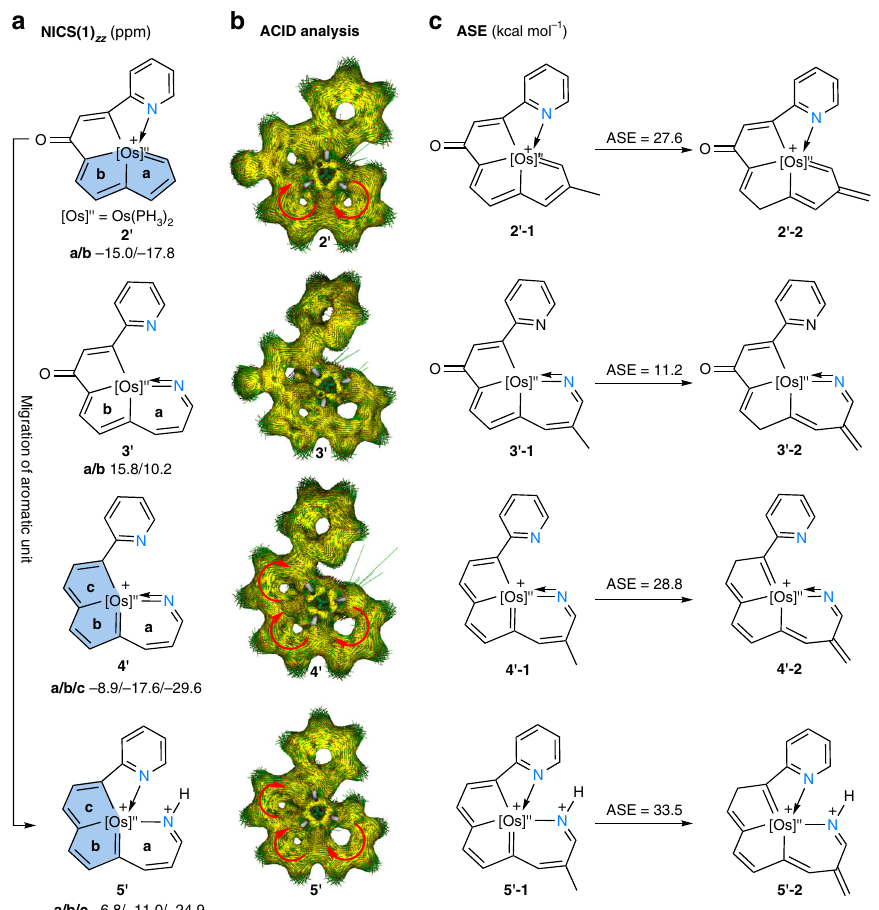
Fig. 5 Aromaticity evaluations. a NICS(1) zz (nucleus-independent chemical shift along the z -axis at 1 Å above the ring critical point, ppm) evaluations of the aromaticity of model complexes 2 ′ – 5 ′ . Blue rings: The migration of the osmapentalene unit from rings ( a , b ) to rings ( b , c ). b Anisotropy of the current- induced density (ACID) plot of model complexes 2 ′ – 5 ′ with an isosurface value of 0.025. The magnetic fi eld vector is orthogonal to the ring plane and points upward. c Aromatic stabilization energy (ASE, kcal mol − 1 ) evaluations of model complexes 2 ′ – 5